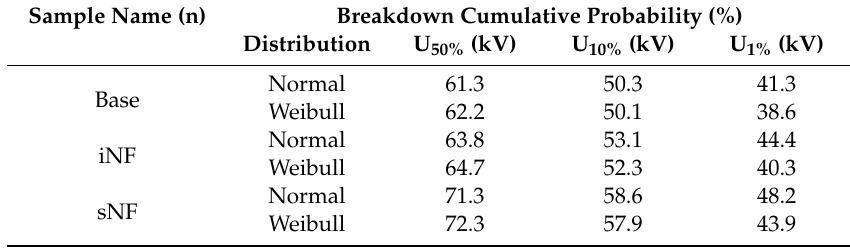
Figure 7. Probability density plots of the breakdown events for each sample in question according to Normal and Weibull distributions.